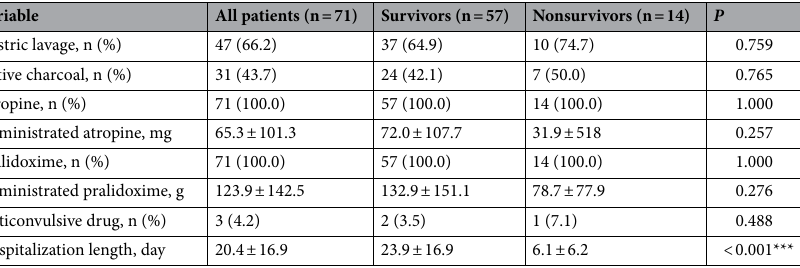
Table 5. Outcomes of elderly patients with organophosphate poisoning, stratified according to status at discharge as survivors or nonsurvivors (n = 71). Categorical variables were presented as numbers with percentages in brackets, while continuous variables were presented as the means and standard deviations. *** P < 0.001.